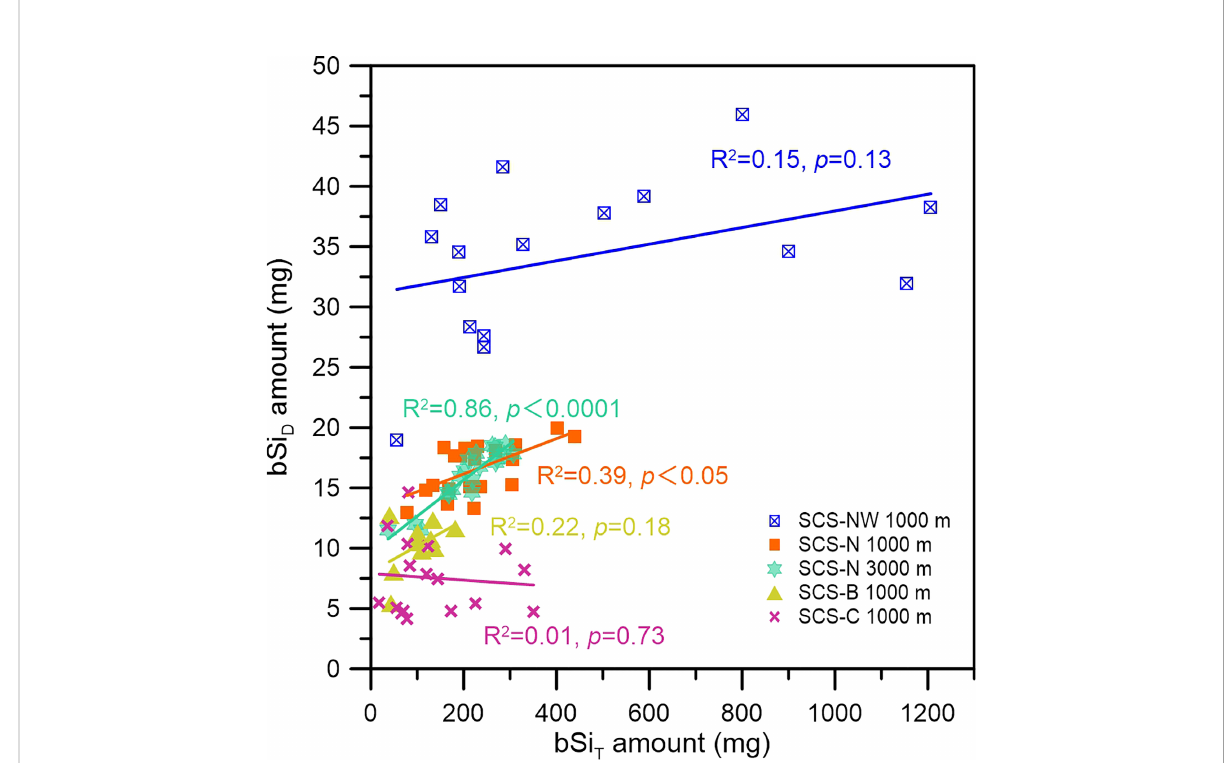
FIGURE 7 Relationship between the bSi D amount and bSi T amount in the sampling bottles at the different stations in the